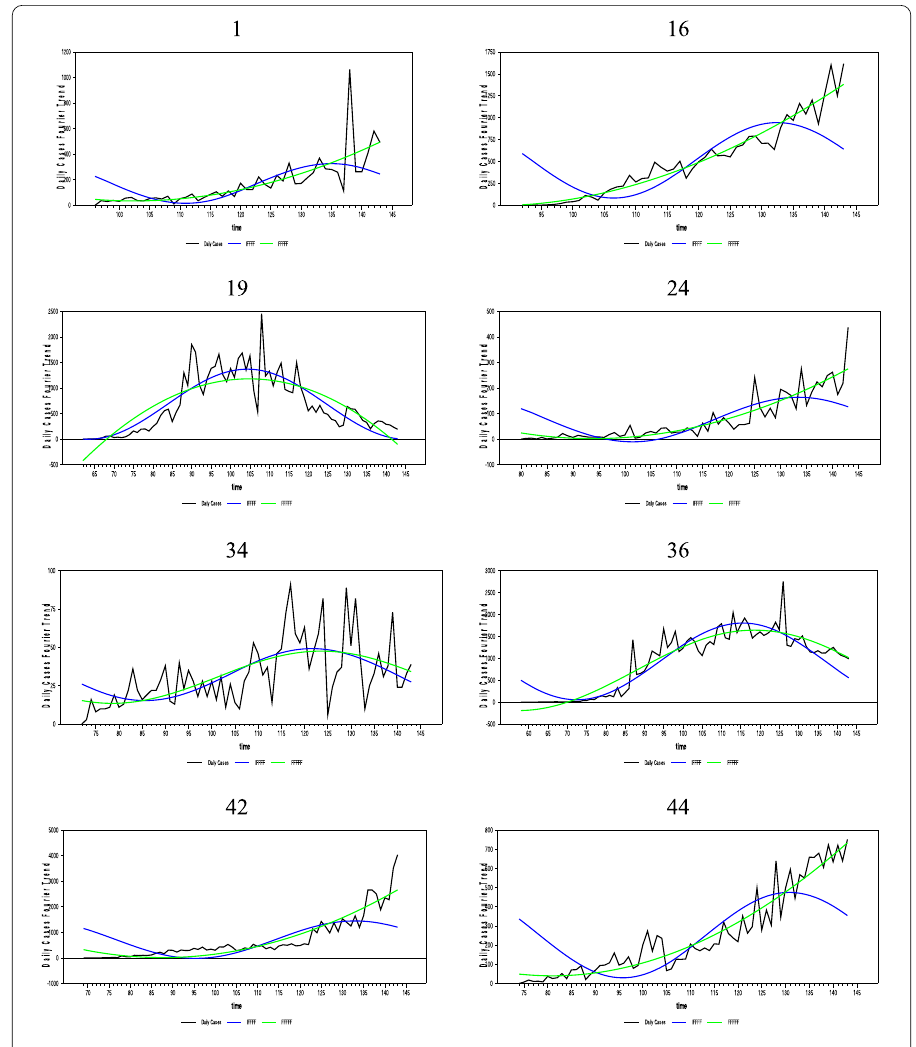
Figure 7 Daily infected cases and the nonlinear trends of FFFFF and IFFFF. The numbers are presenting the selected countries in alphabetic order